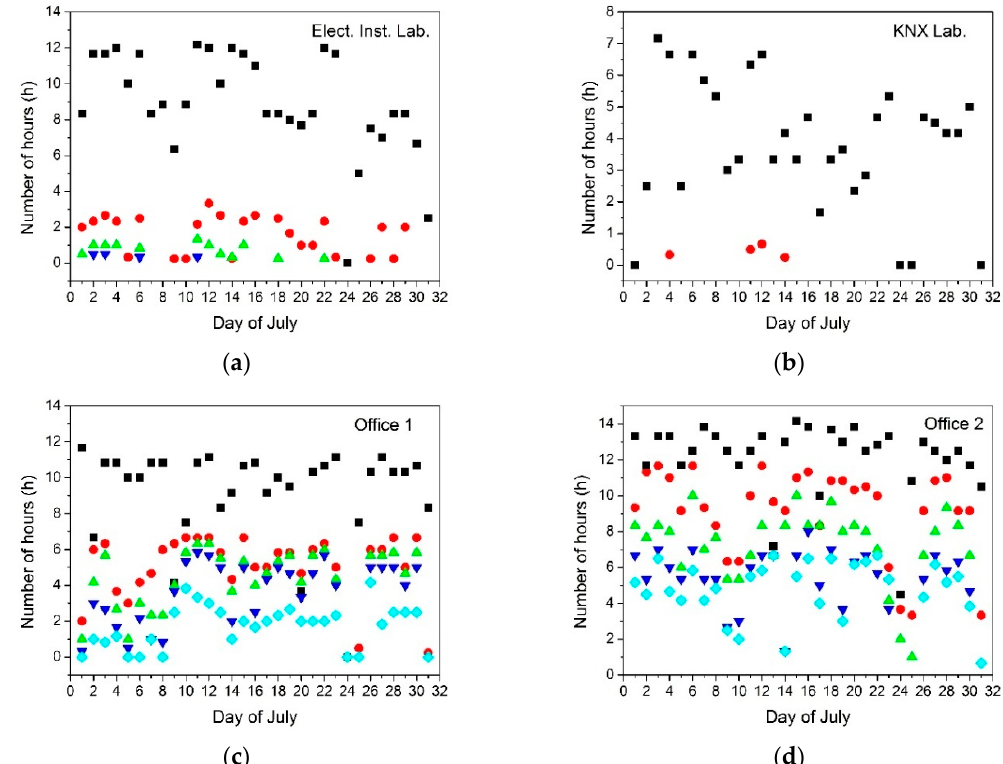
Figure 10. Number of hours in July 2014 for ( a ) Electrical Installations Laboratory, ( b ) KNX Laboratory, ( c ) Office 1, and ( d ) Office 2 with illuminance level higher than: ■ —100 lux, ● —200 lux, ▲ —300 lux, ▼ —400 lux, ♦ —500 lux.